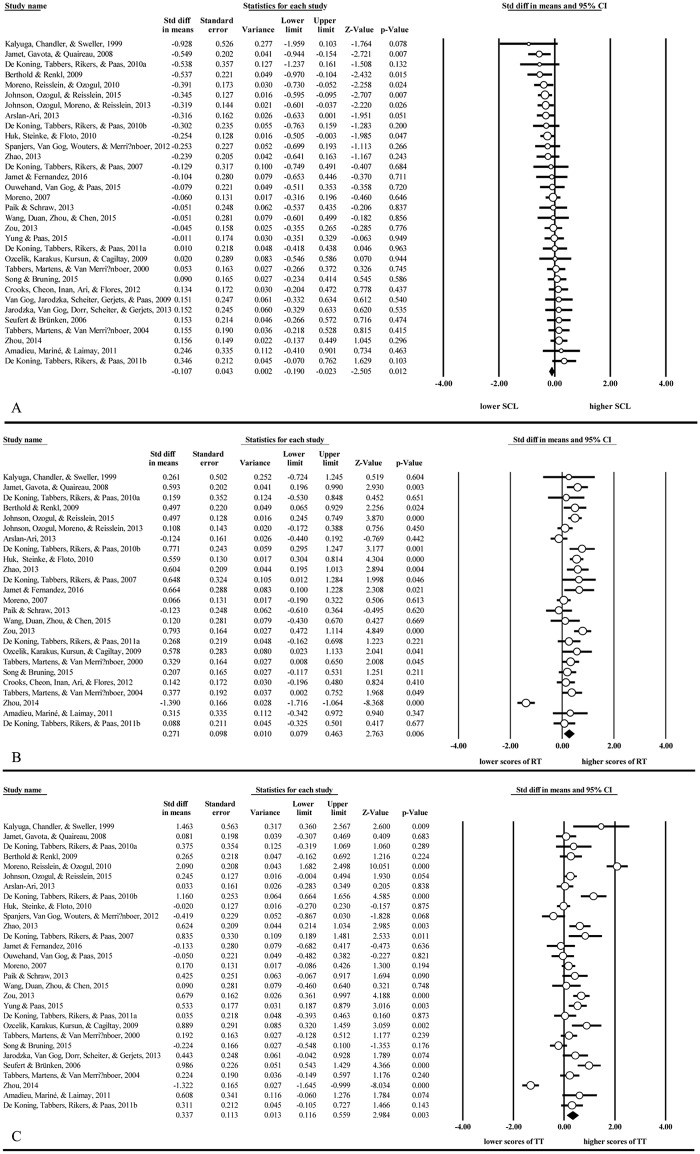
Forest plots of the meta-analysis concerning each index.Note. (A) Meta-analysis of SCL. (B) Meta-analysis of retention test. (C) Meta-analysis of transfer test. Note. RT = retention test, TT = transfer test.